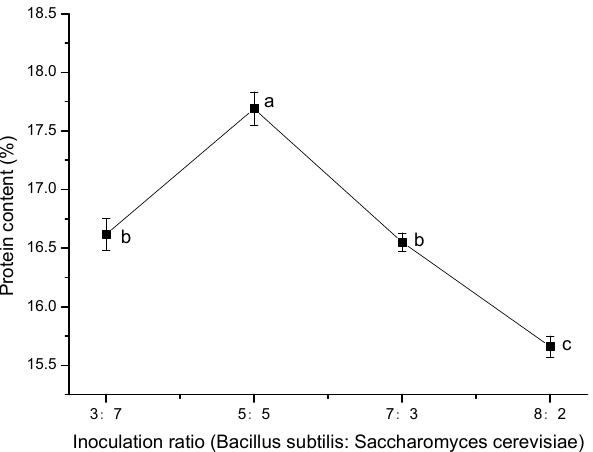
Figure 5. The single-factor experiments for the inoculating proportion in the second stage of the solid-state fermentation. Experiments were performed in triplicate (n = 3). Sites not sharing a common letter showed significant differences ( p < 0.05).